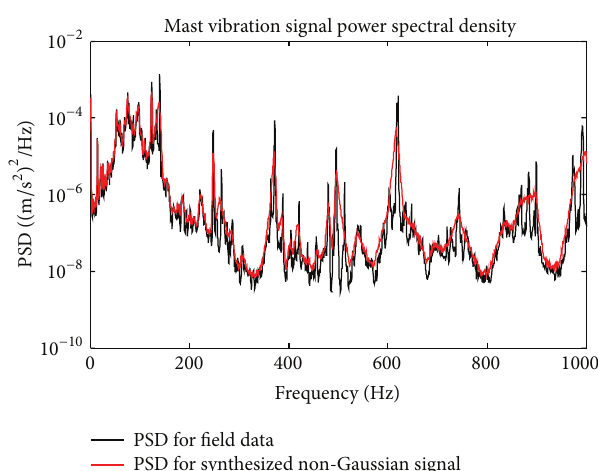
Figure 8: The PSD of the field data and the synthesized non- Gaussian